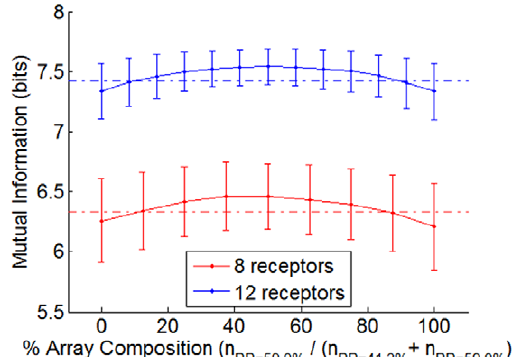
Figure 6. Array performance of heterogeneous ensembles. Mean and standard deviation (after 1,000 repetitions) when mixing receptors with RR=59.0% and receptors with RR=41.3%. Dashed horizontal lines show the maximum performance for 8 and 12 receptors when limited to homogenous arrays. Heterogeneous mixtures perform 0.15 bits better than homogenous arrays.